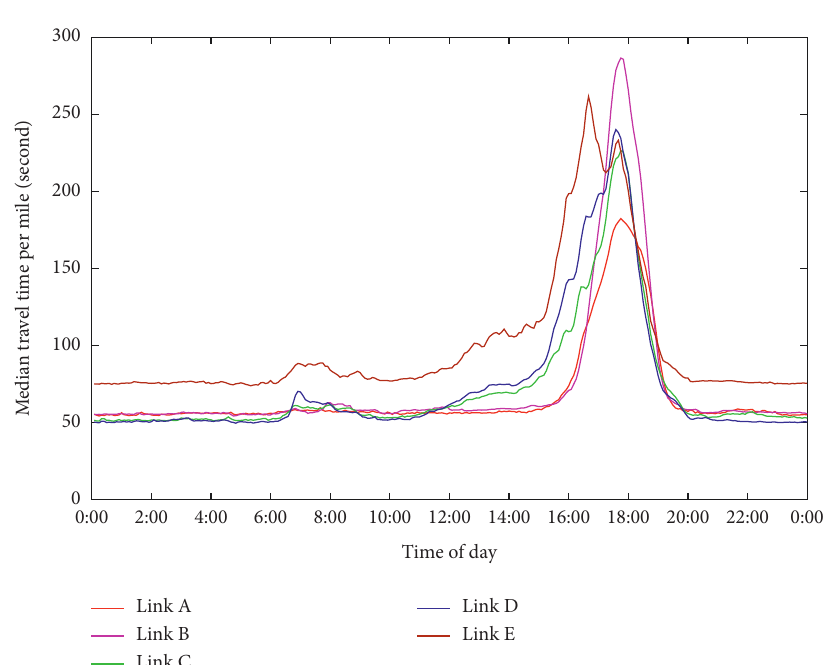
Figure 2: Historical median travel times on the five